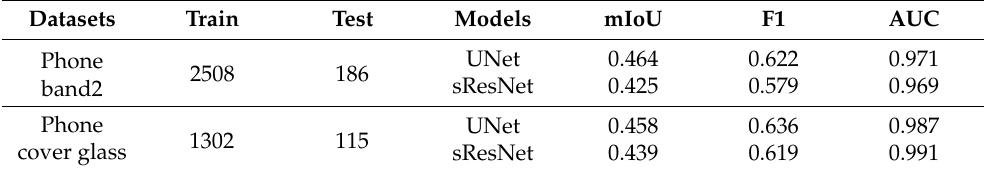
Table 5. The numbers of transferred training sets and real test sets, and the test results of segmentation.